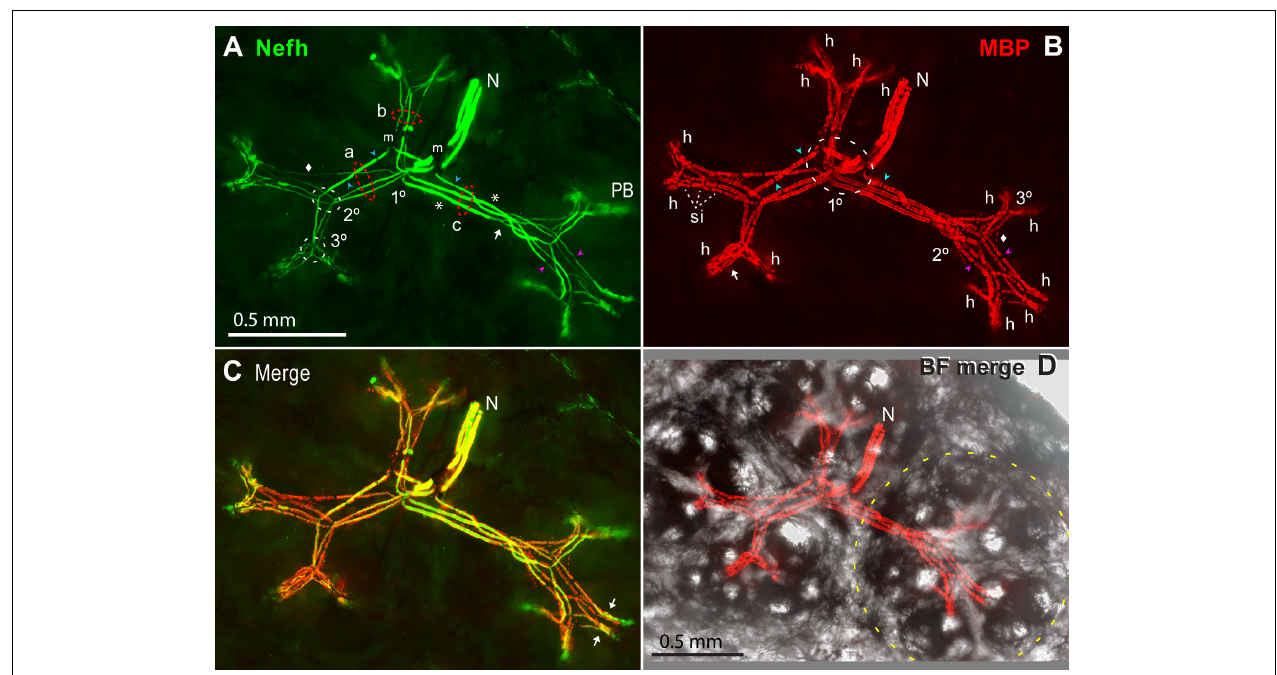
FIGURE 11 | Myelinated afferent arbors of one electroreceptor’s large multipart receptive field on the base of the rostrum. The underside was imaged en bloc (4x 0.13 NA lens) in a thick section parallel to skin, as stack projections. (A) The small nerve (N) with three ALLn sensory neuron axons (Nefh+) of similar large diameter entered the receptive field near its center. 1, 2, 3 ◦ , First, second, or third branch points along myelinated dendrites, proximal-to-distal. Red dashed ovals mark three bundles (a, b, c) of long first-generation myelinated dendrites; each dendritic bundle included three wide and one thin dendrites. These “gen1” dendrites arose from 1 ◦ branch points, and projected to different subclusters of ampullary organs. Gen1 dendrites had 0 ( ) or 1 or 2 ( (cid:74) ) nodes of Ranvier, and ended at 2 ◦ branch points (2 ◦ white dashed oval). Myelinated branch points were networks of narrowed nodes of Ranvier (e.g., arrow near bundle c). The 2 ◦ dendrites had nodes ( (cid:74) ), and diverged to nearby 3 ◦ branch points (3 ◦ white dashed oval). m, Melanin obscured some sites. PB, Projection bundles. (B) Myelin sheaths on afferent dendrite internodes were labeled by anti–myelin basic protein (MBP). Fluorescent background was removed for clarity. The white dashed oval (1 ◦ ) enclosed a zone of first branch points. Gaps in myelin ( (cid:74) , (cid:74) ) corresponded to nodes of Ranvier marked in (A) . Arrow, Parallel MBP+ dendrites of a local gen3,4,5 arbor. h, All 14 candidate spike initiation zones are marked, where MBP+ labeling stopped. si, Short internodes on 2 ◦ dendrites. (A,B) Diamonds mark thin MBP+ branches. (C) Superimposed Nefh+ and MBP+ labeling. Arrows mark single gen3,4,5 arbors, not V-shaped. (D) Correspondence of afferent arbors to the receptive field. MBP+ afferent labeling (as B ) was superimposed on a transilluminated brightfield (BF) image of four rosettes of ampullary organs, one outlined by the yellow dashed line. Small bright circles were skin pores of ampullary